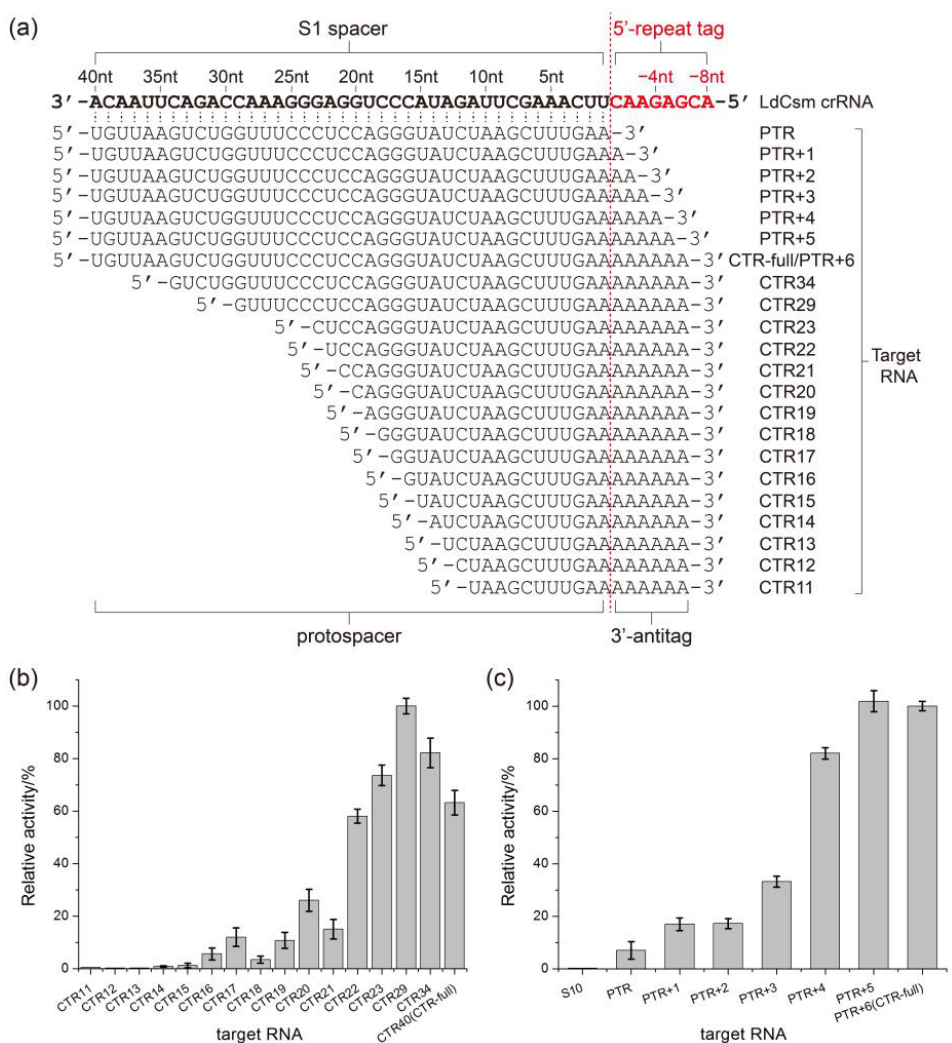
Figure 5. Minimal length of the activator RNA required for the LdCsm-dCsm3 collateral DNase. ( a ) Schematic of designed activator RNAs. The spacer sequence of the crRNA is in bold whereas the 8-nt 5 (cid:48) -repeat tag is highlighted in red. ( b ) Detection activity of LdCsm-dCsm3 in the presence of target RNAs of different lengths. The length of each CTR is indicated with the number of nucleotide sequence that are complementary to the spacer of crRNA. Relative activity of the reaction treated by CTR29 is set as 100%. ( c ) Detection activity of LdCsm-dCsm3 activated by target RNAs carrying various lengths of the 3 (cid:48) -antitag. S10 is an unspecific RNA, serving as a negative control. Protospacer target RNA (PTR) is the target RNA without any 3 (cid:48) -antitag sequence. Relative activity of the reaction treated by CTR-full is set as